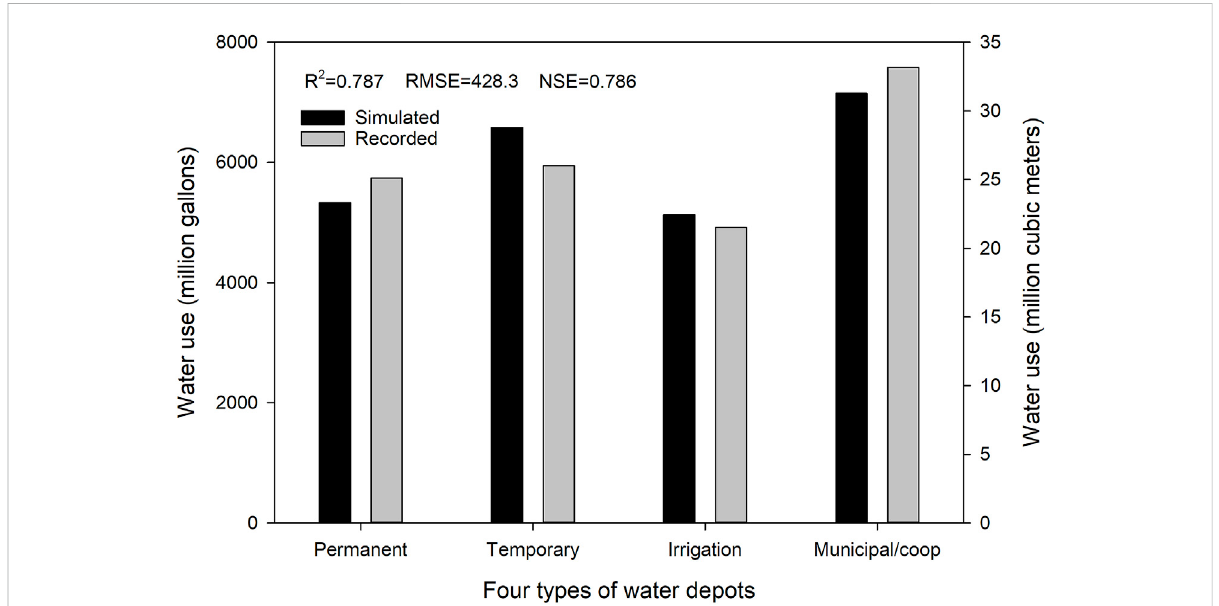
FIGURE 7 Graphical comparison of the recorded and model-simulated water uses of the four different types of water depots in 2008 – 2014. Notes: RMSE – Root Mean Square Error, NSE – Nash-Sutcliffe Ef fi ciency.